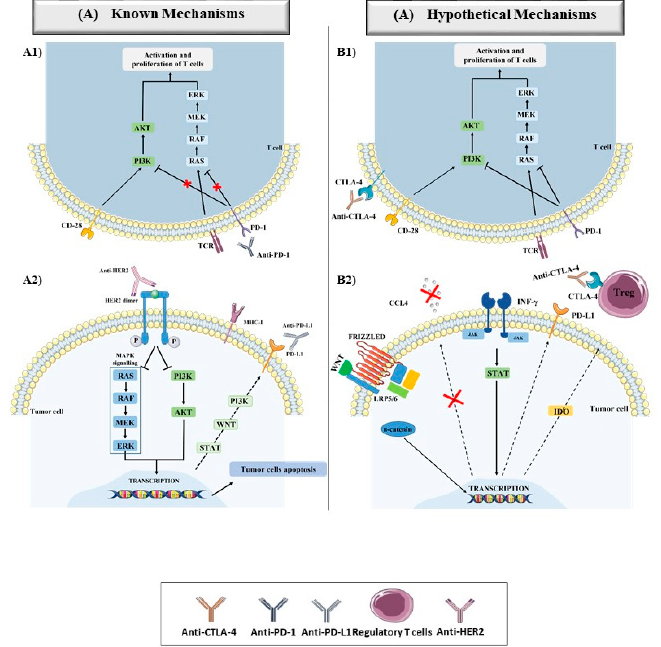
Figure 5. Known and hypothetical target pathways in breast cancer immunotherapeutic treatment.